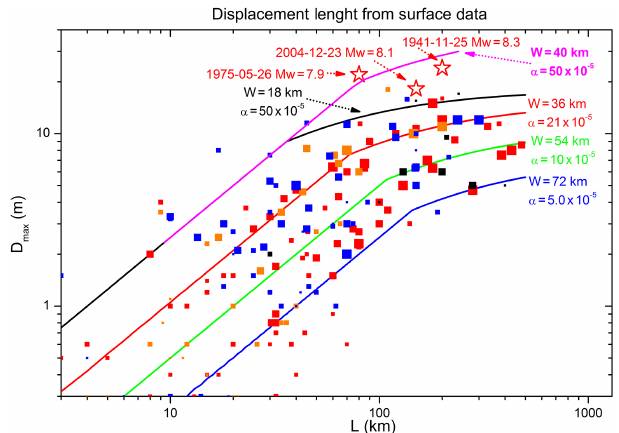
Figure 3. Maximum displacement versus fault length derived from surface measurements (adapted from Manighetti et al. 2007): red squares, strike-slip events; orange squares, dip-slip events; blue squares, composite faults. The black squares were not used in the regression analysis. The size of the symbols is proportional to the quality of the data. Also represented are the four typical laws selected by the automatic regression of Manighetti et al. (2007; coloured lines). The data points for the Gloria Fault and Tasman Sea earthquakes are plotted as red stars, and the magenta line de- picts the adopted scaling law (see text for